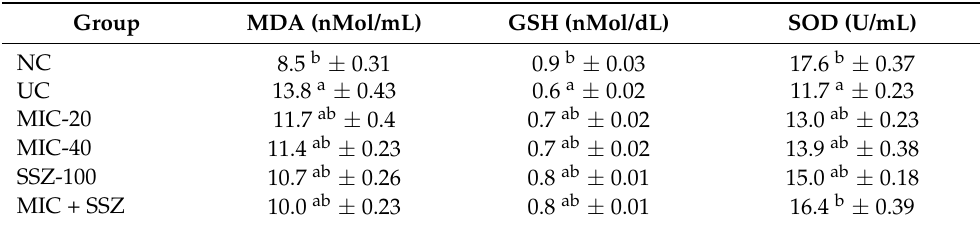
Each group’s values are expressed as the mean ± SEM of seven animals. a Significantly different at p ≤ 0.05 from the negative control (NC) values. b Significantly different at p ≤ 0.05 from the ulcerative colitis control (UC)